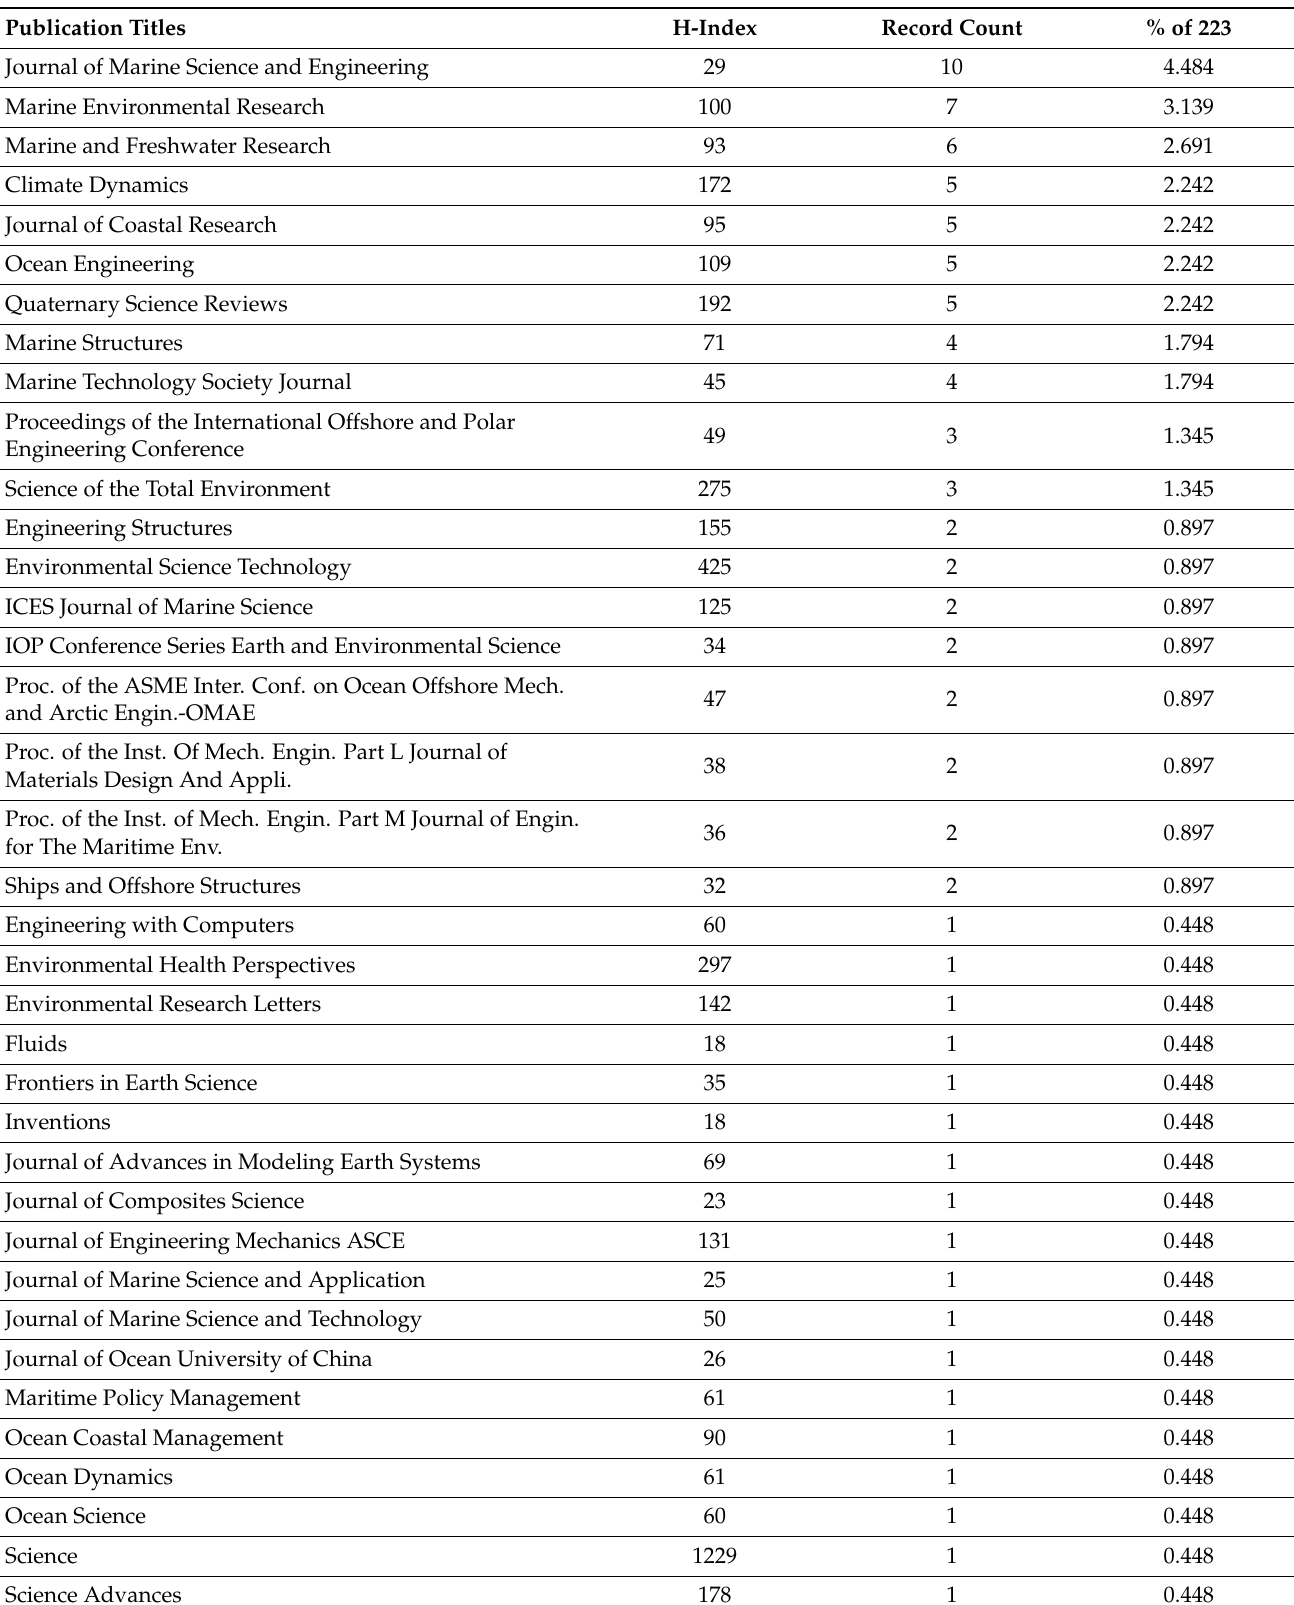
Table 2. Funding details of the top funders on marine hose research (data retrieved from WoS database, 24 July